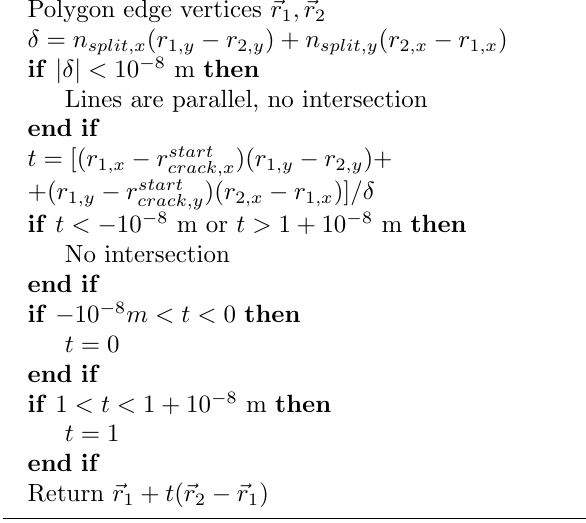
Figure 23: Splitting crack propagation criterion. Value